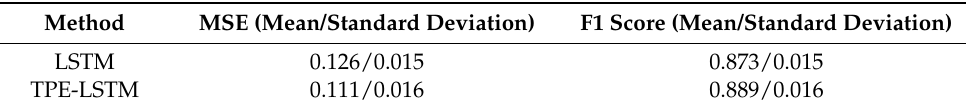
Table 10. The classification performance: LSTM selected for improvement versus TPE-LSTM. Aggre- gated Cleveland + Statlog